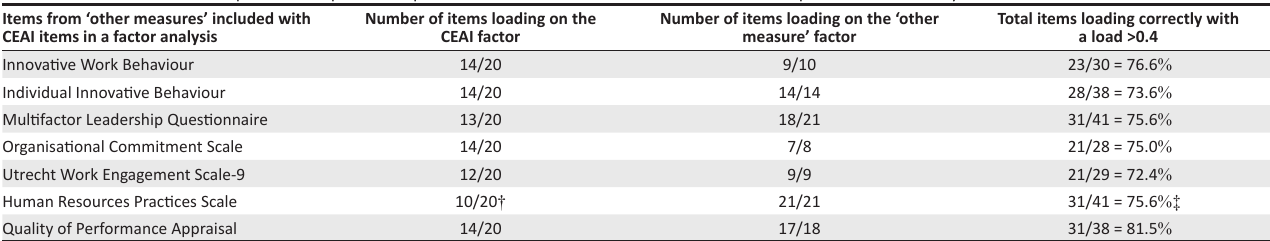
TABLE 7: Distinctiveness of Corporate Entrepreneurship Assessment Instrument items and other items exposed to factor analysis. Items from ‘other measures’ included with CEAI items in a factor analysis